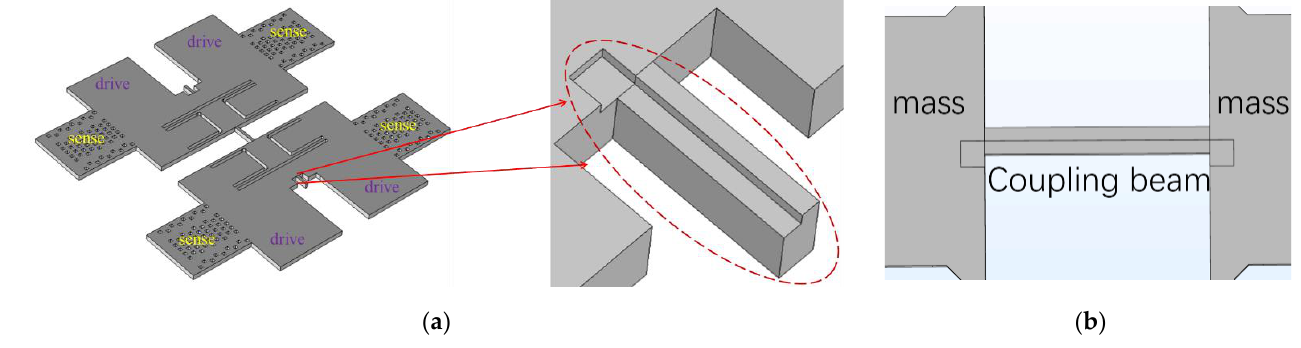
Figure 1. ( a ) A schematic illustration of the BFVG structure; ( b ) back of coupling beam.